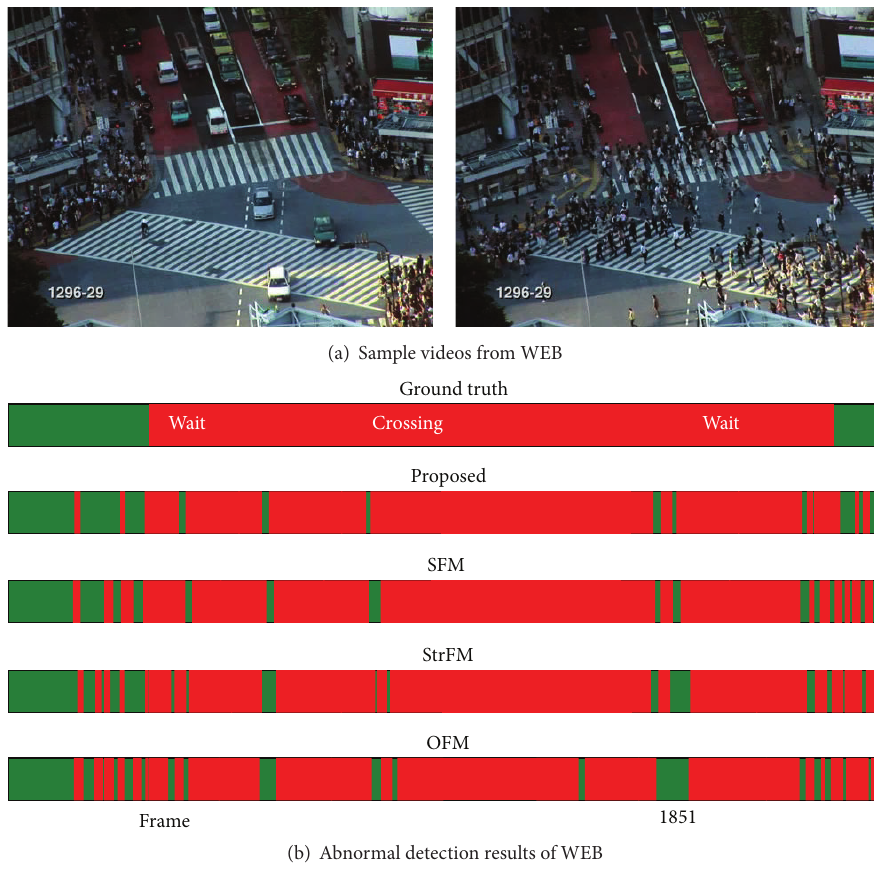
Figure 9: Comparison results of abnormal detection for sample videos from WEB.